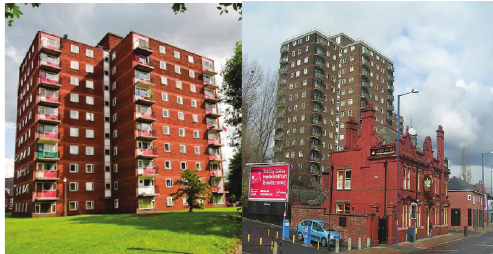
Figure 1: City West Housing Trust high-rise blocks before works. Source : author.